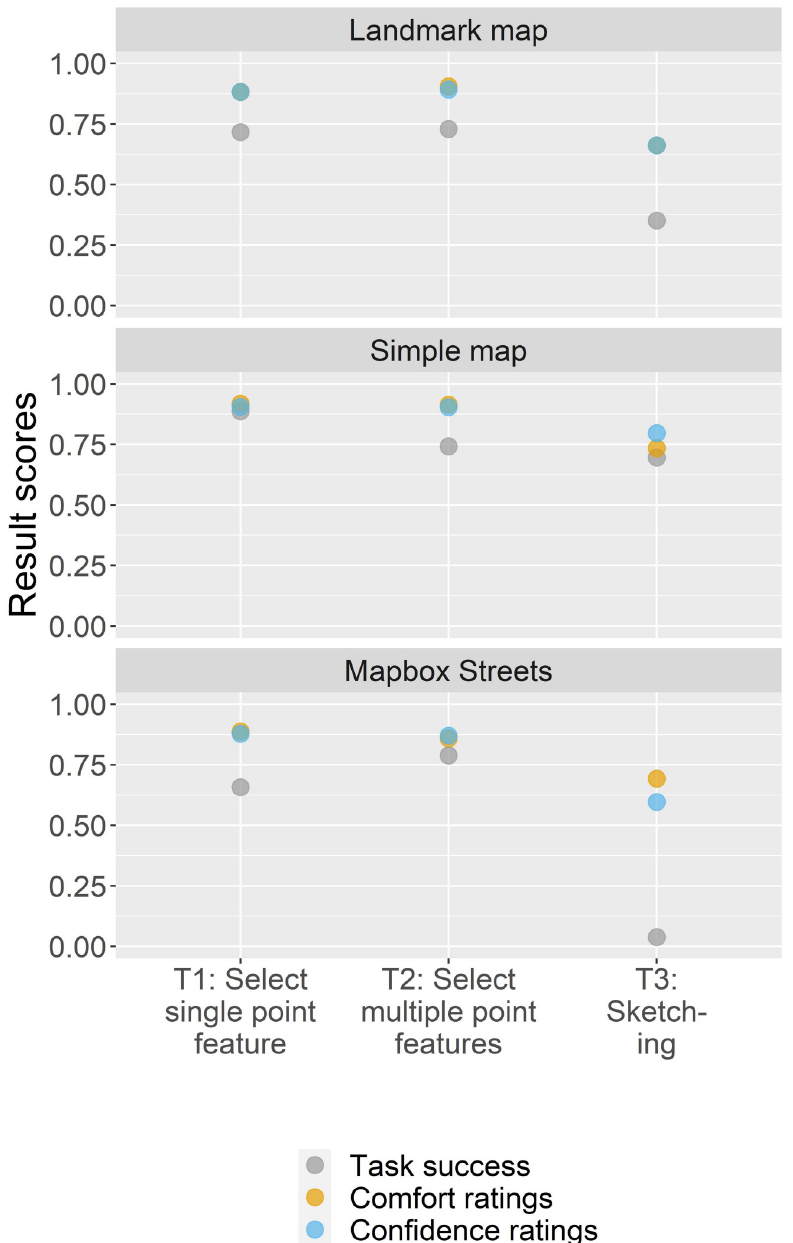
Fig 9. Task success, comfort, and confidence ratings of map design